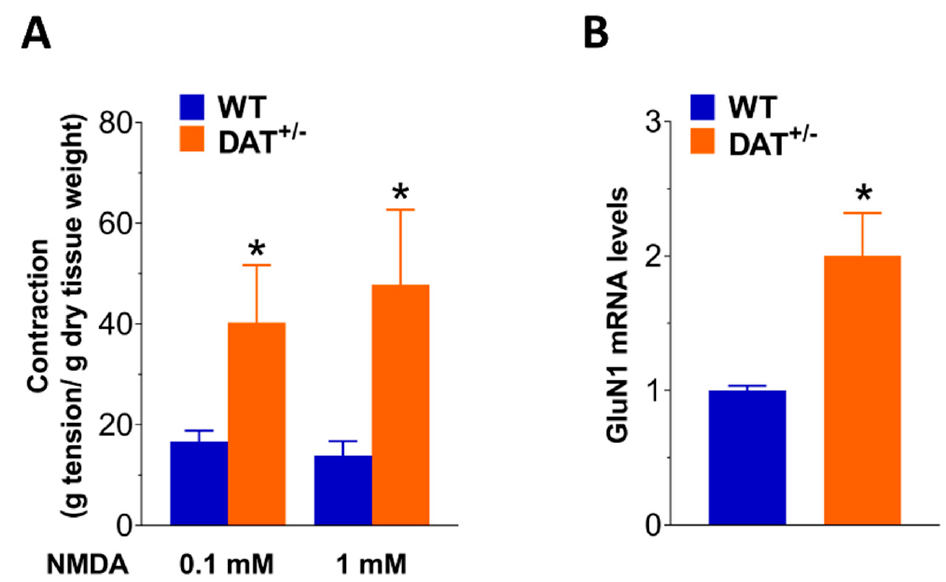
Figure 6. DAT hypofunction influences glutamatergic neurotransmission. ( A ) 0.1 mM and 1 mM NMDA-induced contractions in isolated ileal preparations of WT and DAT +/ − mice. ( B ) GluN1 mRNA levels in LMMP preparations of WT and DAT +/ − mice. Data are reported as mean ± SEM. * p < 0.05 vs. WT mice. n = 5 mice/group.